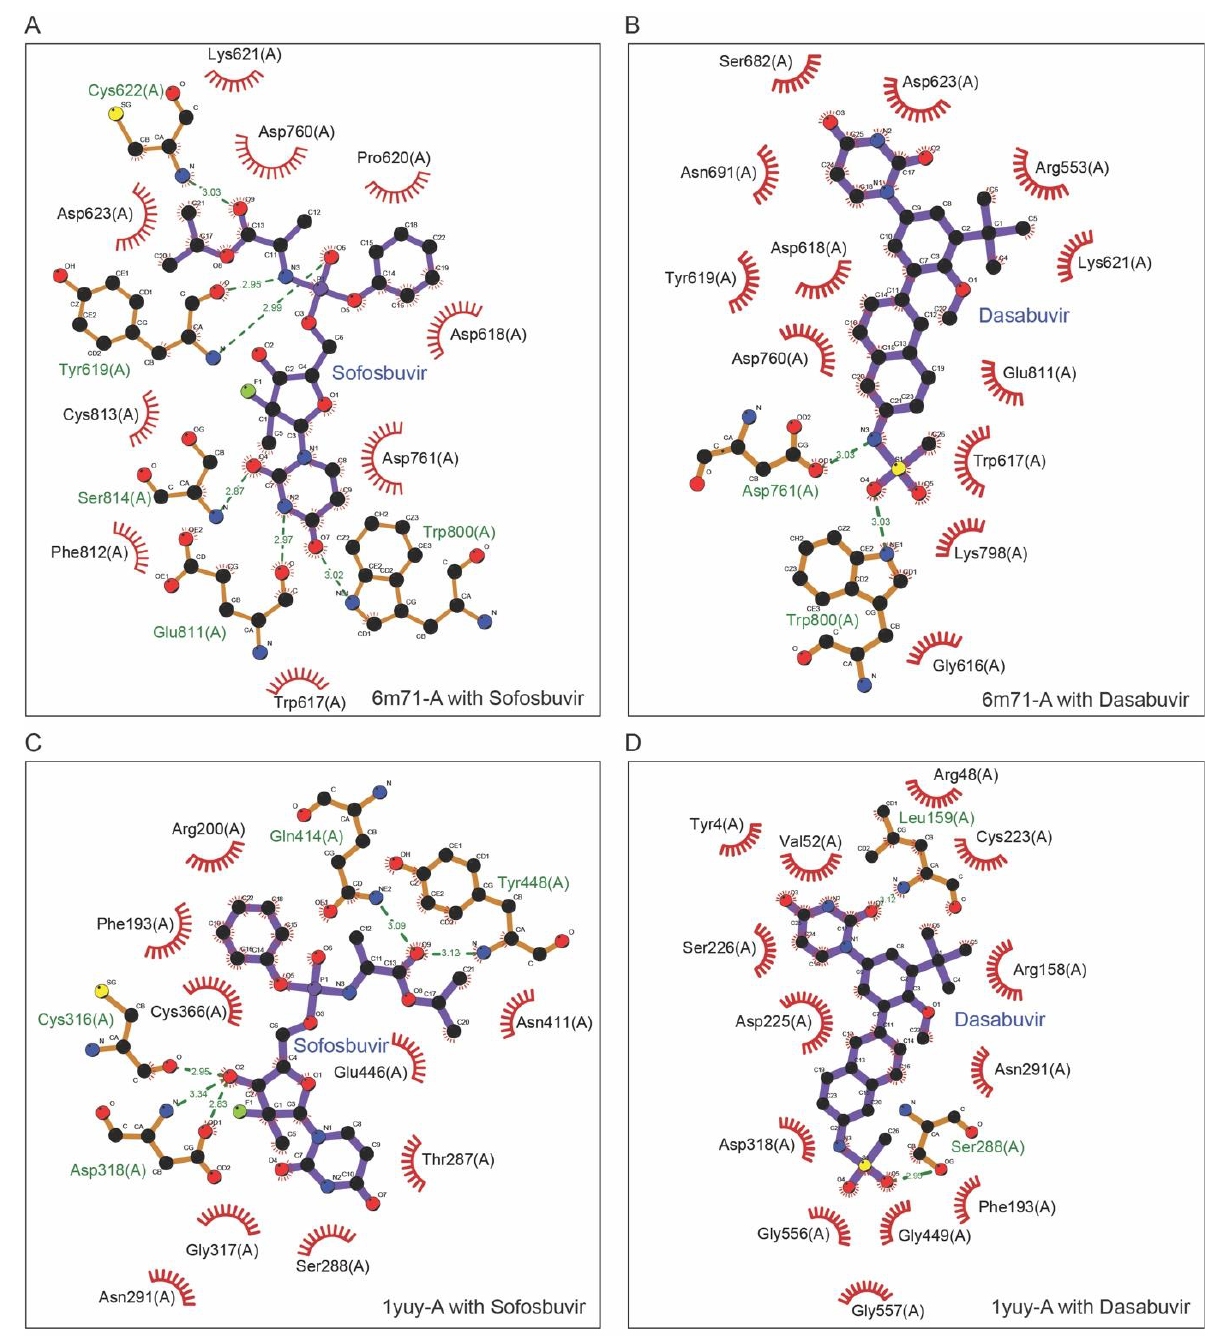
Figure 4. Receptor–ligand interaction profiling. The interactions between receptors, i.e., Nsp-12 and NS5B and ligands, i.e., Sofosbuvir and Dasabuvir. The dotted green line represents hydrogen bonding while the residues shown participate in hydrophobic interactions. ( A ) Interactions between NSP-12 and Sofosbuvir. ( B ) Interactions between NSP-12 and Dasabuvir. ( C ) Interactions between NS5B and Sofosbuvir. ( D ) Interactions between NS5B and Dasabuvir.